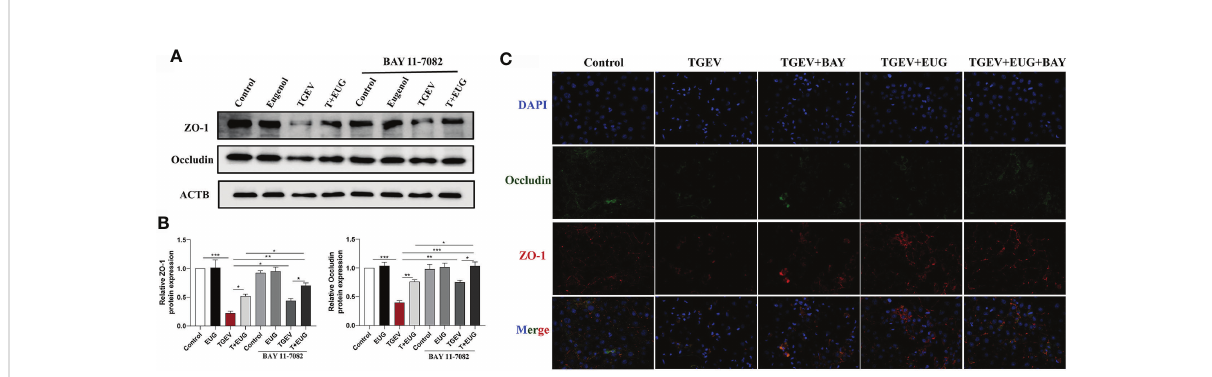
FIGURE 12 Eugenol alleviates TGEV-induced intestinal barrier dysfunction through the NF- k B signaling pathway. IPEC-J2 cells were pretreated with eugenol (200 m M) or BAY 11-7082(1 m M) for 1 h and then infected with TGEV for 36 h. (A, B) Immunoblot analysis and quanti fi cation of ZO-1 and Occludin in IPEC-J2 cells. (C) Representative images of ZO-1 and Occludin by immuno fl uorescence staining in IPEC-J2 cells. Scale bar, 50 m m. Data were expressed as mean ± SEM. * p < 0.05, ** p < 0.01, *** p <